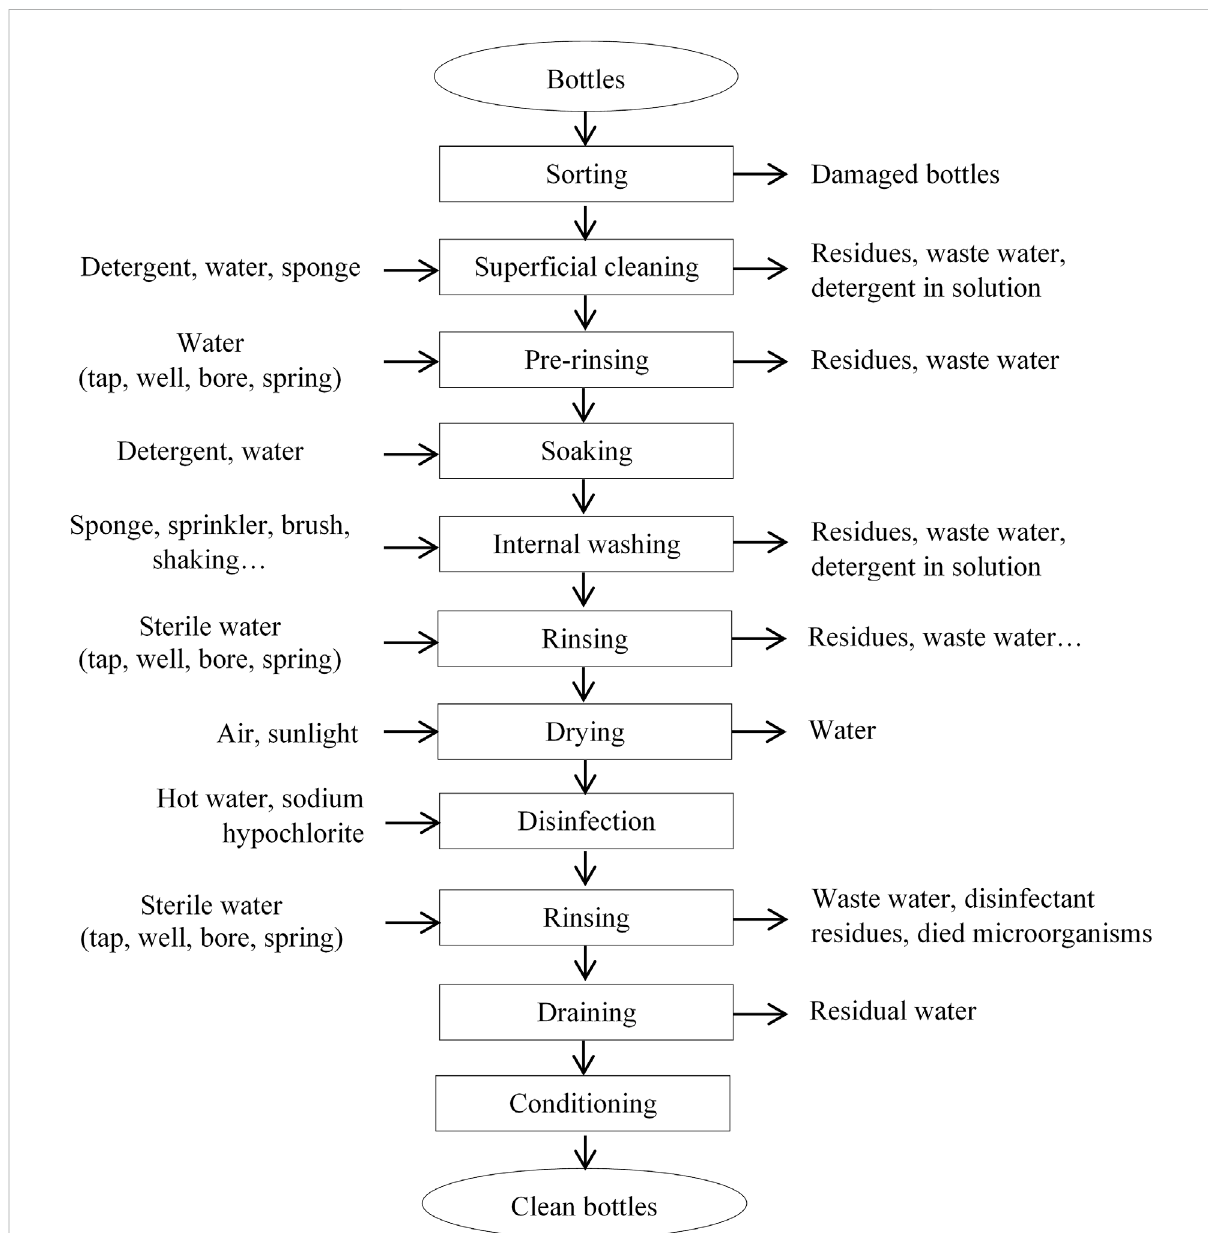
FIGURE 2 Standard fl ow chart proposed for the cleaning process of recovered bottles used for traditional food packaging in the city of Yaoundé.